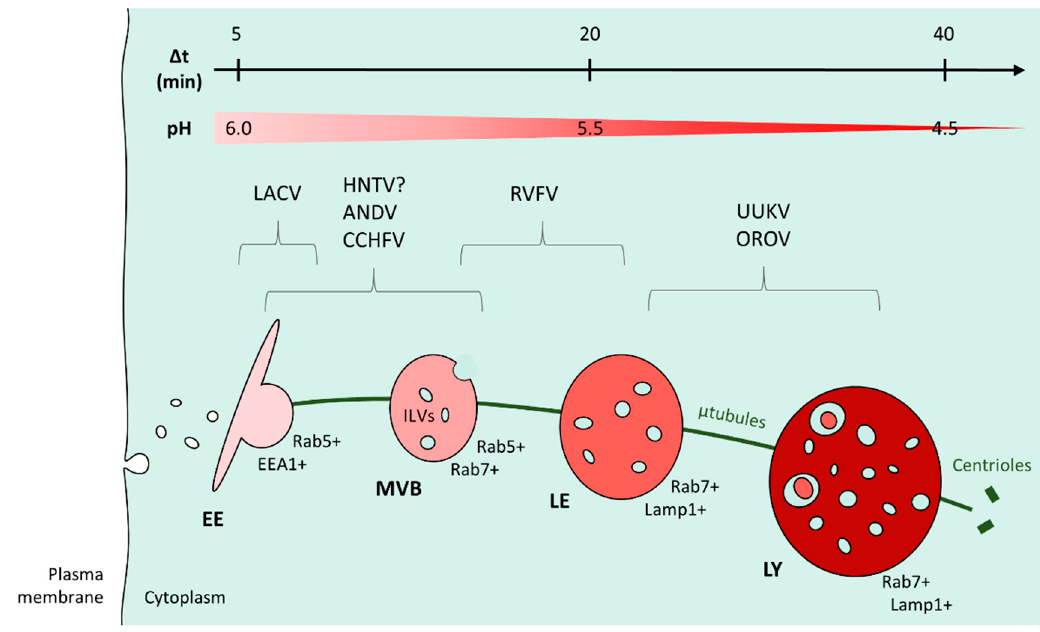
Figure 5. Bunyavirus intracellular trafficking. This figure shows an overview of the different potential locations of bunyavirus penetration. On the top, the scales indicate the time required by a cargo to traffic from the plasma membrane to an organelle ( Δ t) and the pH inside the endosomes